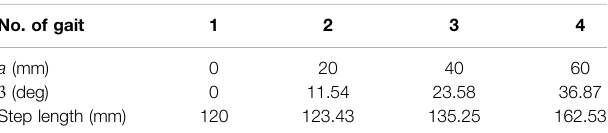
TABLE 3 | Variation of adjustable parameters and step length of the leg mechanism.